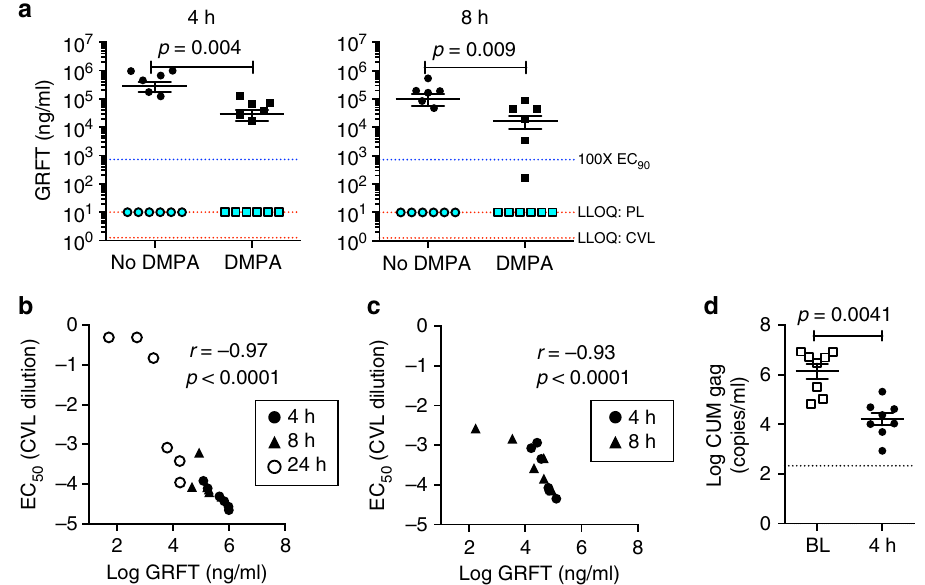
Fig. 3 GRFT in vivo release and activity. a For PK evaluation, GRT/CG FDIs were inserted vaginally in macaques either treated or not 4 weeks prior with DMPA. GRFT concentrations are shown in CVL (black symbols) and plasma (aqua symbols) at 4 h (left) and 8 h (right) post-insertion. Separate groups of macaques were assayed at each time point. The mean ± SEM is indicated by line and error bars for each group of 6 macaques. GRFT was not detected in plasma (PL) above the lower limit of quanti fi cation (LLOQ) of the assay, which was 10 ng/ml (top red dotted line), and so the values are shown at the LLOQ. The LLOQ for CVL was 1.25 ng/ml (bottom red dotted line). The 100-fold EC 90 level, 724.4 ng/ml, is also indicated (blue dotted line). Concentrations of GRFT in CVL from DMPA-treated and non-DMPA-treated macaques and between 4 and 8 h in DMPA-treated macaques were compared by two-sided Mann – Whitney test and p values are shown for α < 0.05. b GRFT concentrations in CVLs from non-DMPA-treated macaques and ( c ) from DMPA-treated macaques correlated with the EC 50 of the CVLs using Spearman correlation analysis. Spearman correlation coef fi cient ( r ) and signi fi cance of the association ( p value) are shown. d Anti-SHIV SF162P3 activity of CVLs from non-DMPA-treated macaques was analyzed in human ectocervical explants. Tissue infection level (CUM SIV gag copies/ml) was compared between the Baseline (BL) and 4 h (4 h) post insertion using a log- normal mixed effects two-sided ANOVA model with time points and animal IDs nested within the experiment assumed as fi xed and random effects, respectively. Four CVLs selected at random from the 6 macaques per time point were each tested twice for 8 replicates total. CVLs were collected from the same macaques at baseline and 4 h post-insertion. Mean± SEM is indicated for each group by line and error bars